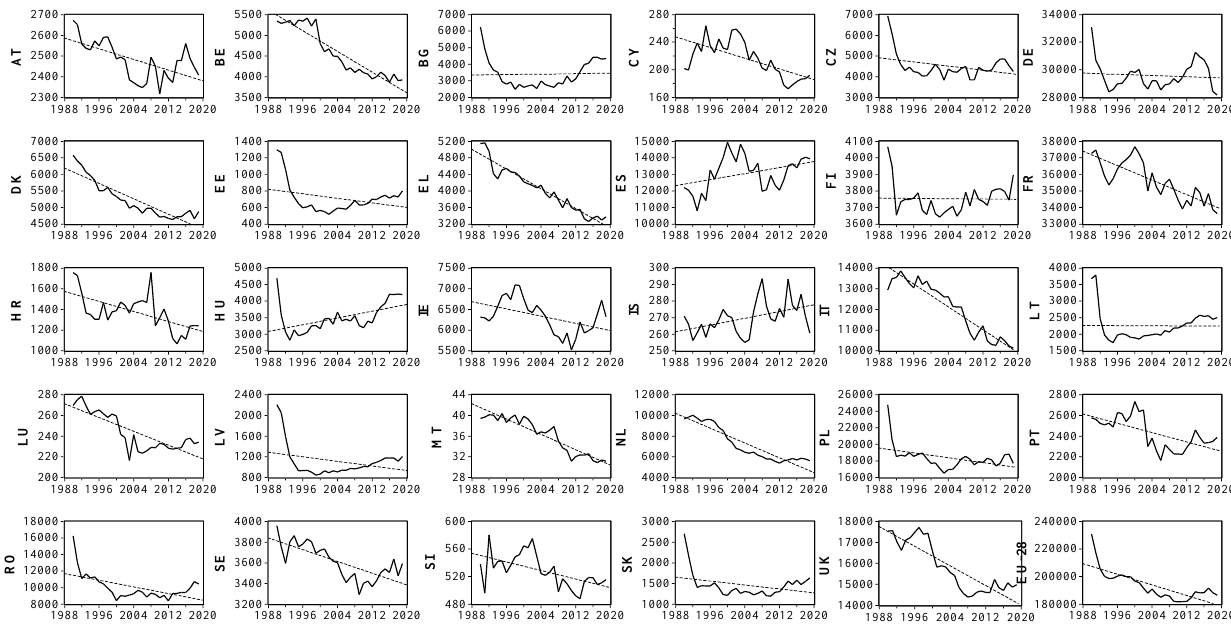
Figure 3. Time evolution of CH 4 emissions between 1990 and 2019 within EU-28 (agricultural sector).